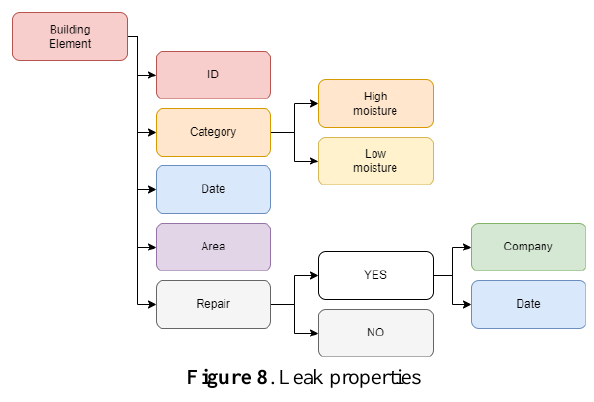
Figure 8 . Roof leaks in BIM environment